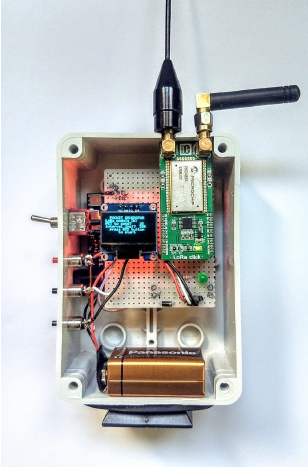
Figure 5. LoRa Field Packet Generator.